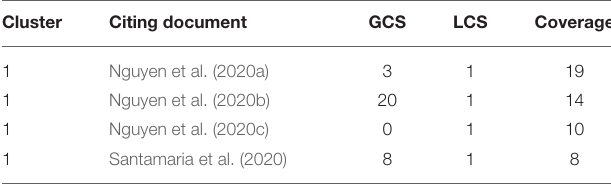
TABLE 5 | Citing documents in cluster #1 identified using the DCA.